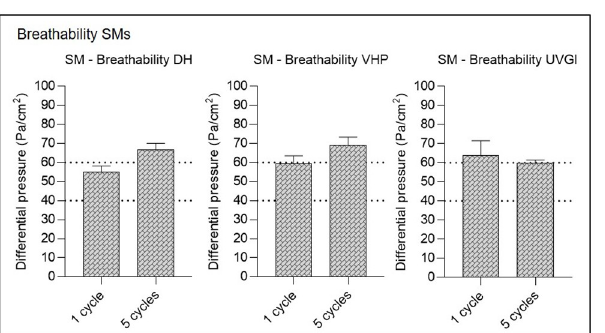
Fig 5. Surgical mask (SM) breathability testing after single-cycle or multiple-cycle decontamination using dry heat (DH), vaporised hydrogen peroxide (VHP), and ultraviolet germicidal irradiation (UVGI). Horizontal dotted lines represent the maximum allowed differential pressure in following standards: < 40 Pa/cm 2 according to EN 14683:2019 Annex C for Type I and II masks and < 60 Pa/cm 2 for Type IIR. Untreated SMs (n = 5) achieved 52.08 ( ± 0.99) Pa/cm 2 differential pressure as a baseline before